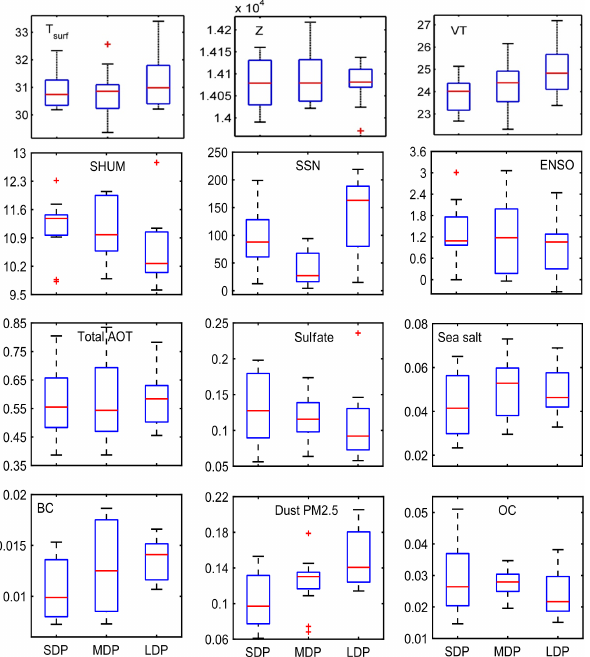
Figure 7. Frequency distribution analysis results of various control- ling factors behind DDF evolution for various types of dry phase lengths over region 3, namely surface temperature, geopotential, VT, humidity, SSN, ENSO, total aerosols, sulfates, sea salt, BC, dust PM 2 . 5 and